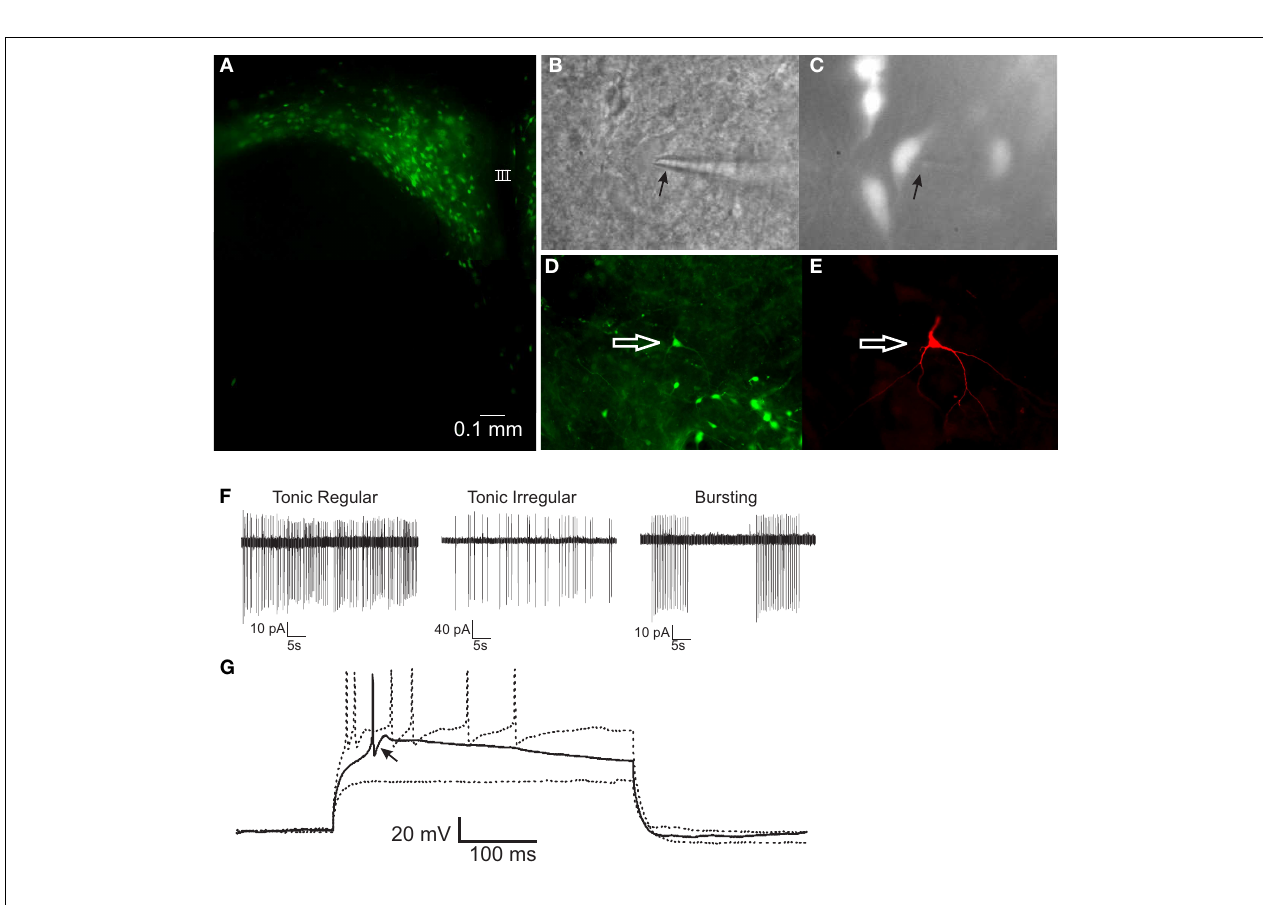
Fluorescence image of the recorded cell [same as in (D) ] filled with biocytin and visualized with an Avidin-Texas Red conjugate. (F) Loose-patch recordings of action potential activity demonstrating typical firing patterns in three PRV-152 labeled, gastric-related PVN neurons. (G) Current-clamp recording from a gastric-related preautonomic neuron that generated a low-threshold spike (arrow) in response to depolarizing current pulses (70–90pA) from a membrane potential of − 90mV [same neuron as shown in (D,E) ]. III, third